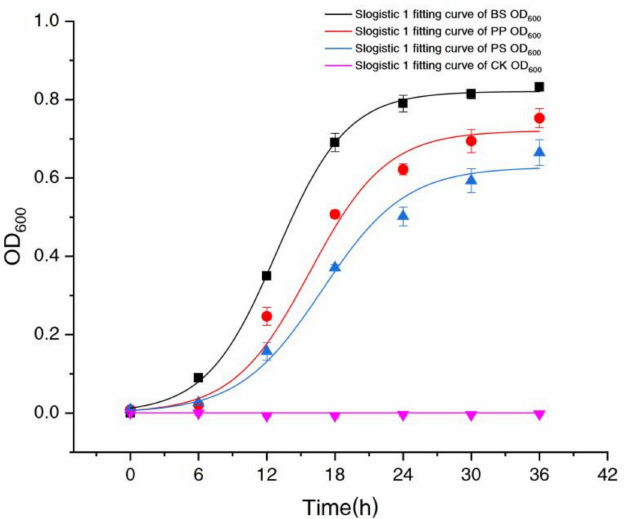
Figure 1. Fitting growth curves of Bacillus subtilis (BS), Pseudomonas stutzeri (PS) and Pseudomonas putida (PP).